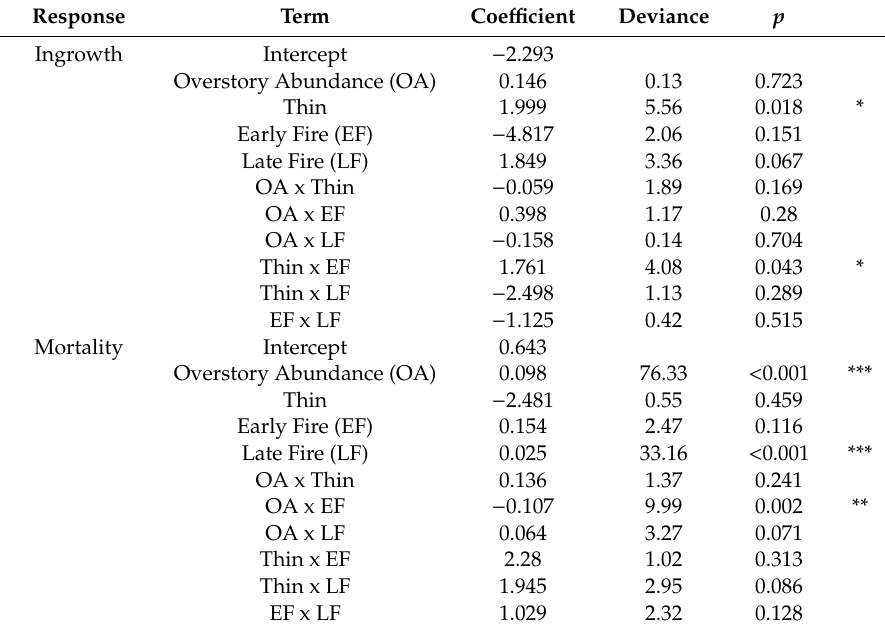
Table A2. Model results for ingrowth and mortality, two aspects of overstory dynamics, during the Early to Late interval ( n = 72 plots). Each response was analyzed with a GLM with a negative binomial distribution. Total deviance was 73.85 for ingrowth and 209.60 for mortality. Coe ffi cients are not back-transformed to original units. Statistical significance was evaluated using a chi-square test of the deviance explained by the term (df = 1 for all terms).